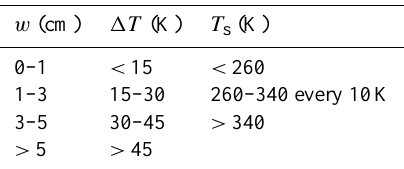
Table 3. Precipitable water ( w ), lapse rate ( (cid:49)T ), and surface skin temperature ( T s ) intervals used to determine LW and WN ADMs under clear-sky conditions over the ocean, land, and desert. There are 4 w bins, 4 (cid:49)T bins, and 10 T s